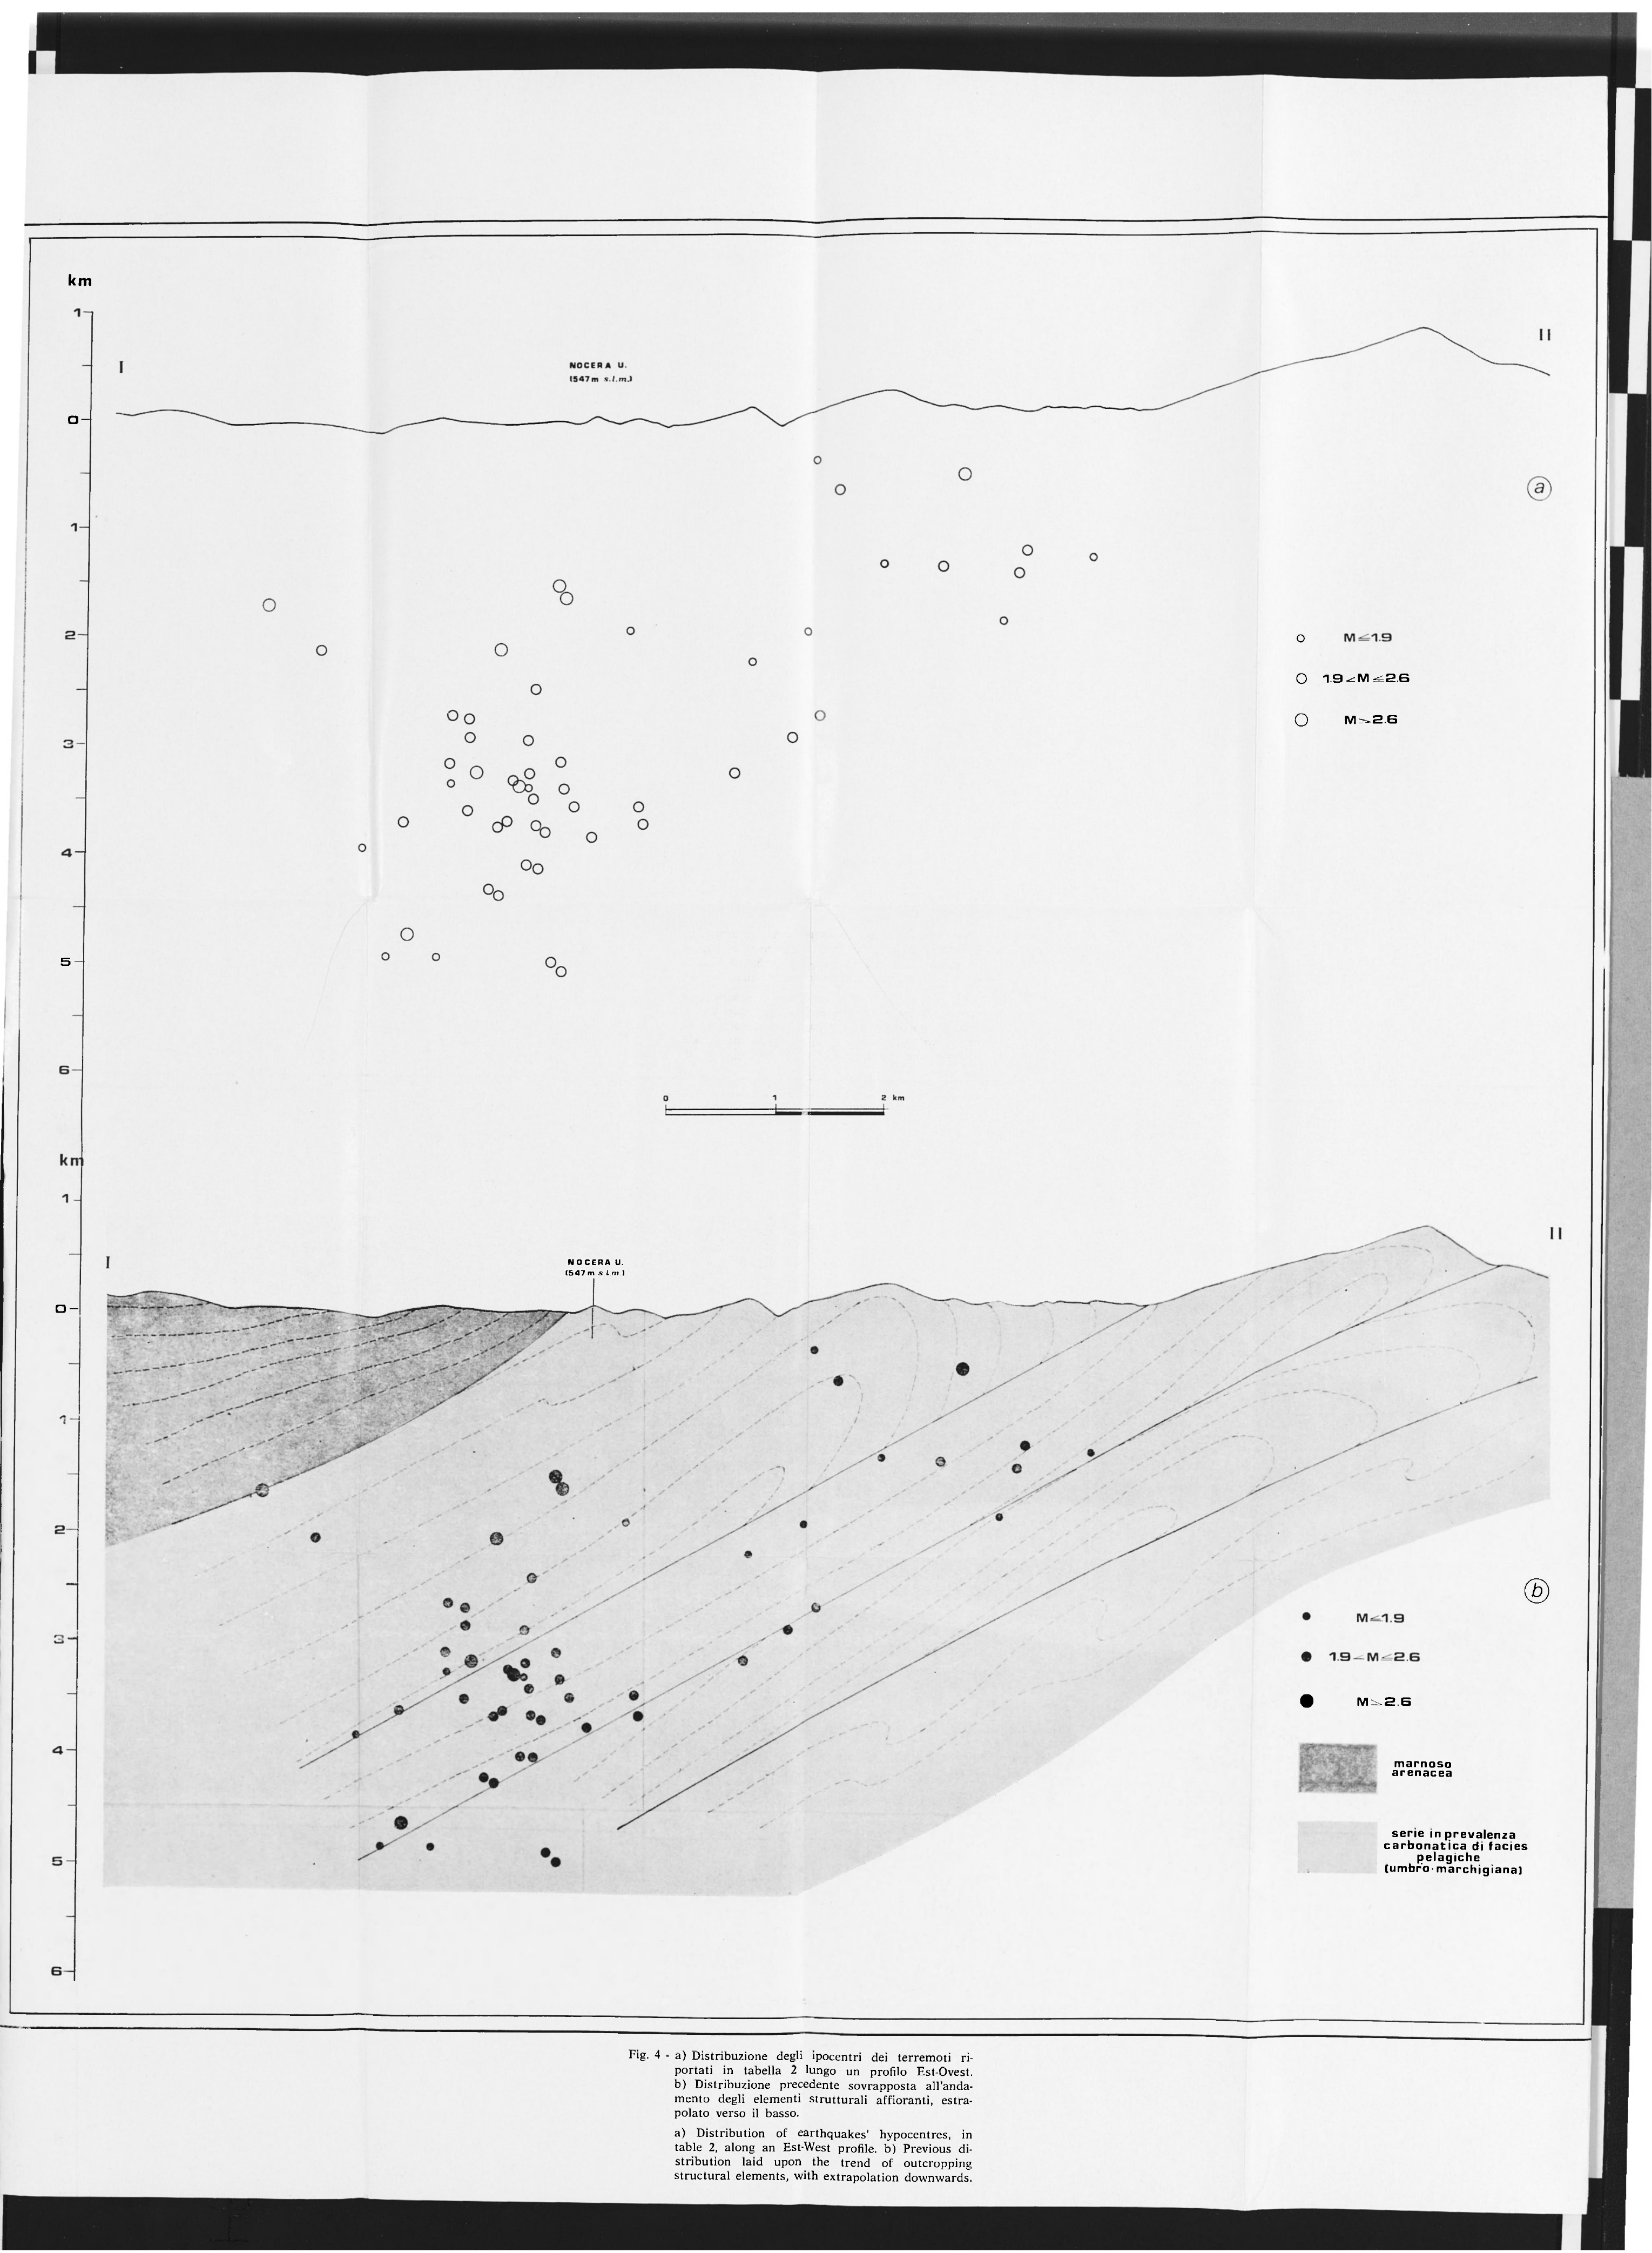
table 2, along an Est-West profile, b) Previous di- stribution laid upon the trend of outcropping structural elements, with extrapolation